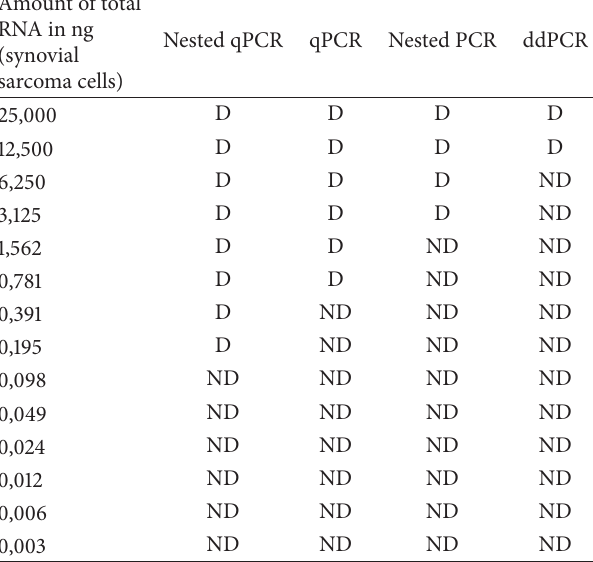
Table 1: Comparison of sensitivity of nested PCR, qPCR, nested PCR, and ddPCR in the detection of the SYT-SSX2 fusion gene in synovial sarcoma cells. D: detected, ND: not